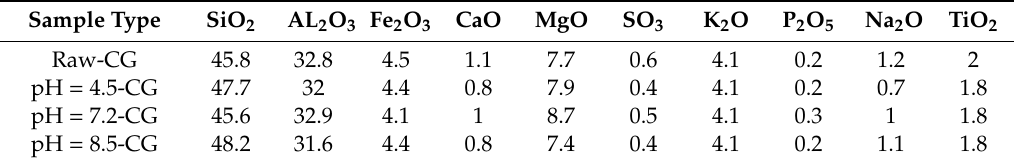
Table 5. Content of each oxide in the coal gangue samples by XRF / %.